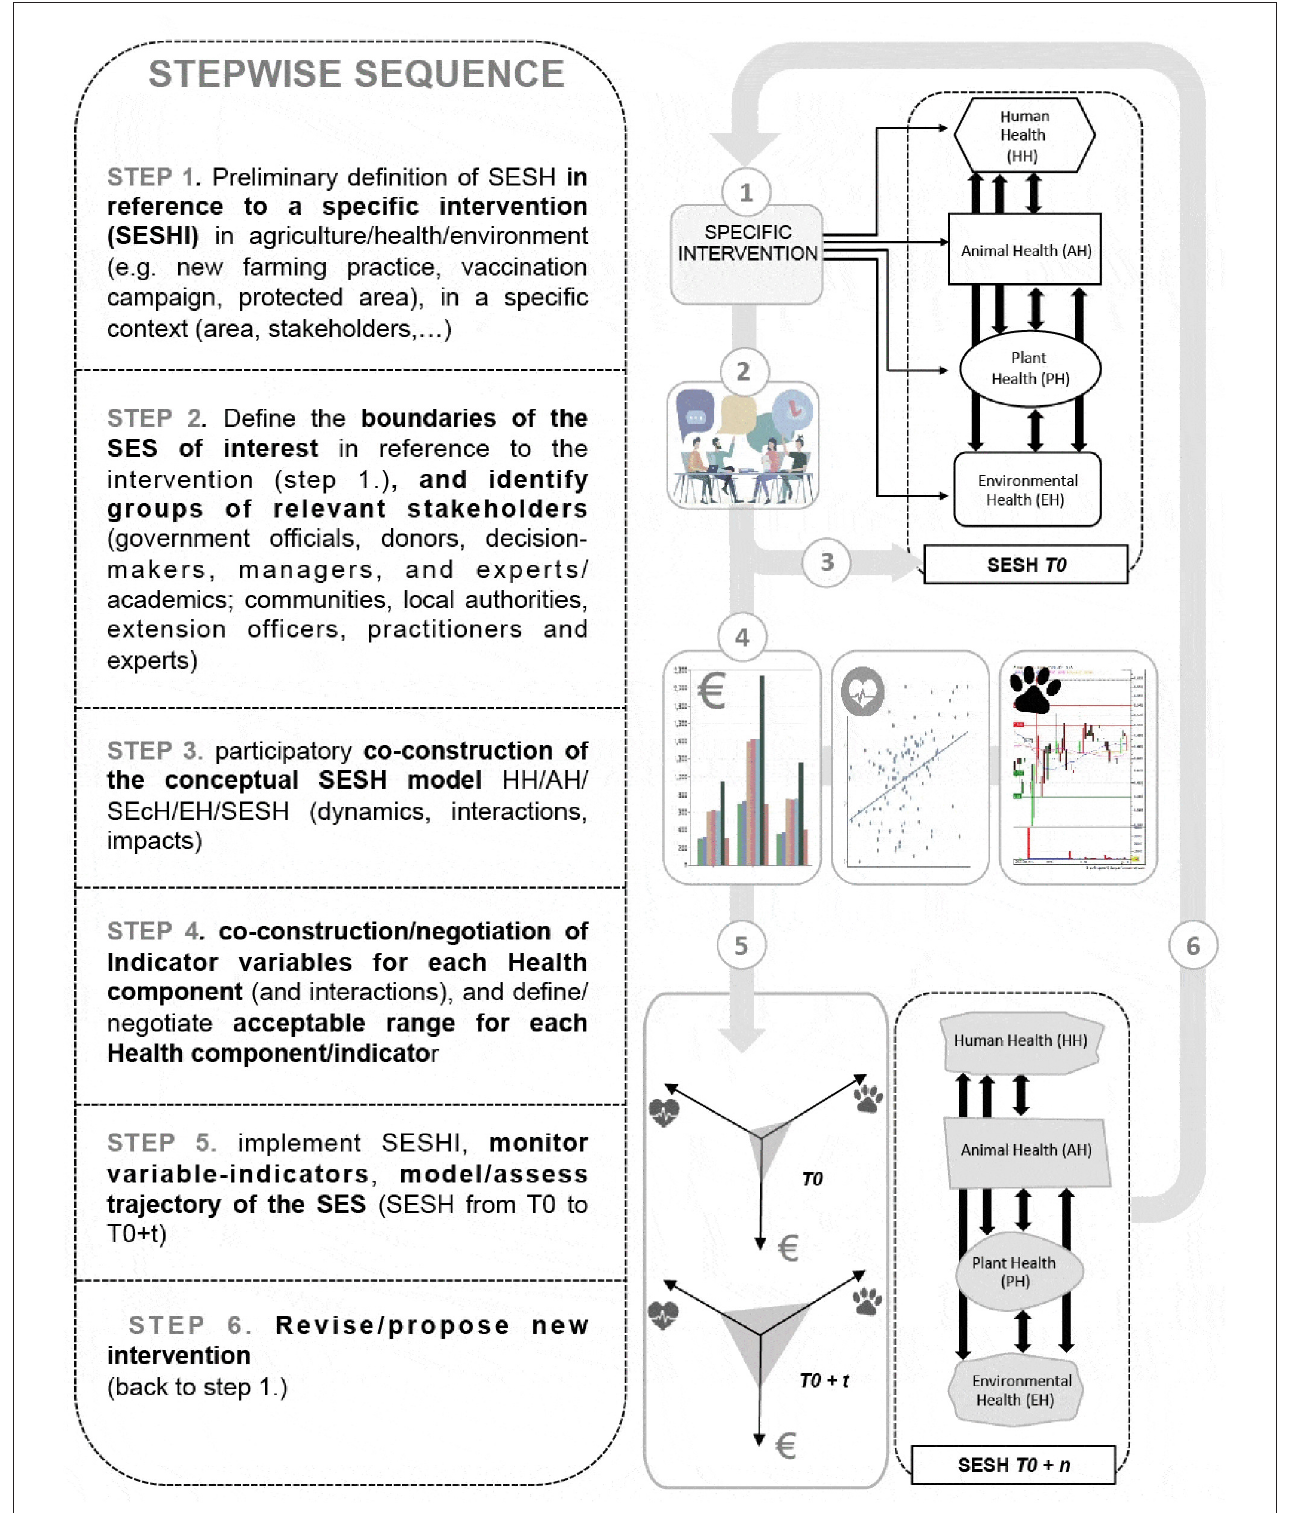
FIGURE 2 | SESH operational stepwise